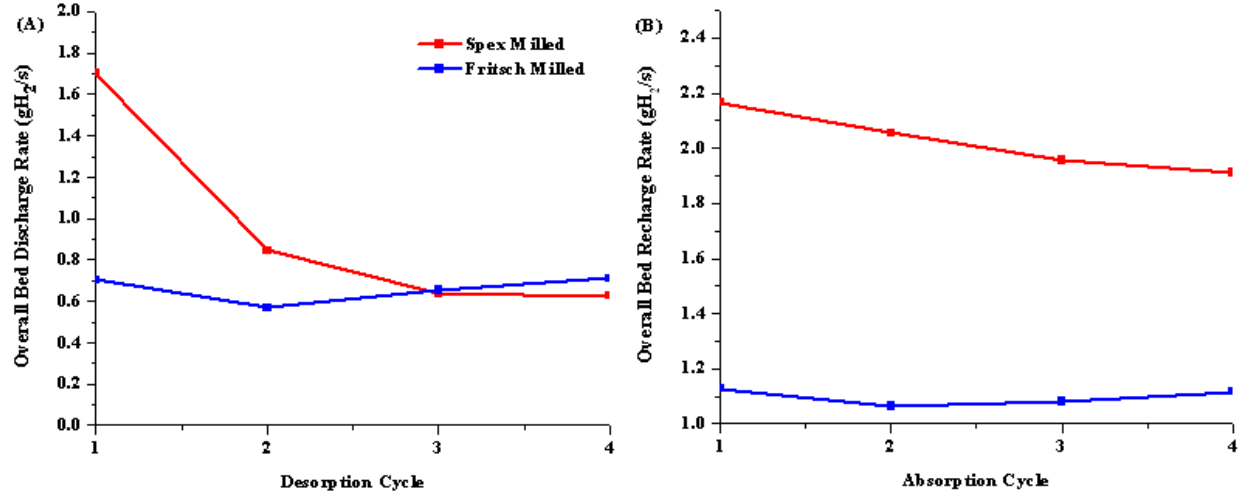
Figure 6. Overall bed discharge ( A ) and recharge ( B ) rate in gH Fritsch (blue) milled